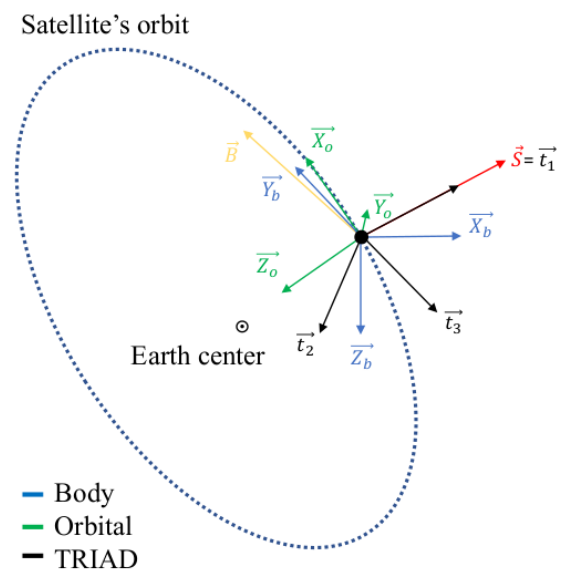
Figure 7. Reference frames for TRIAD